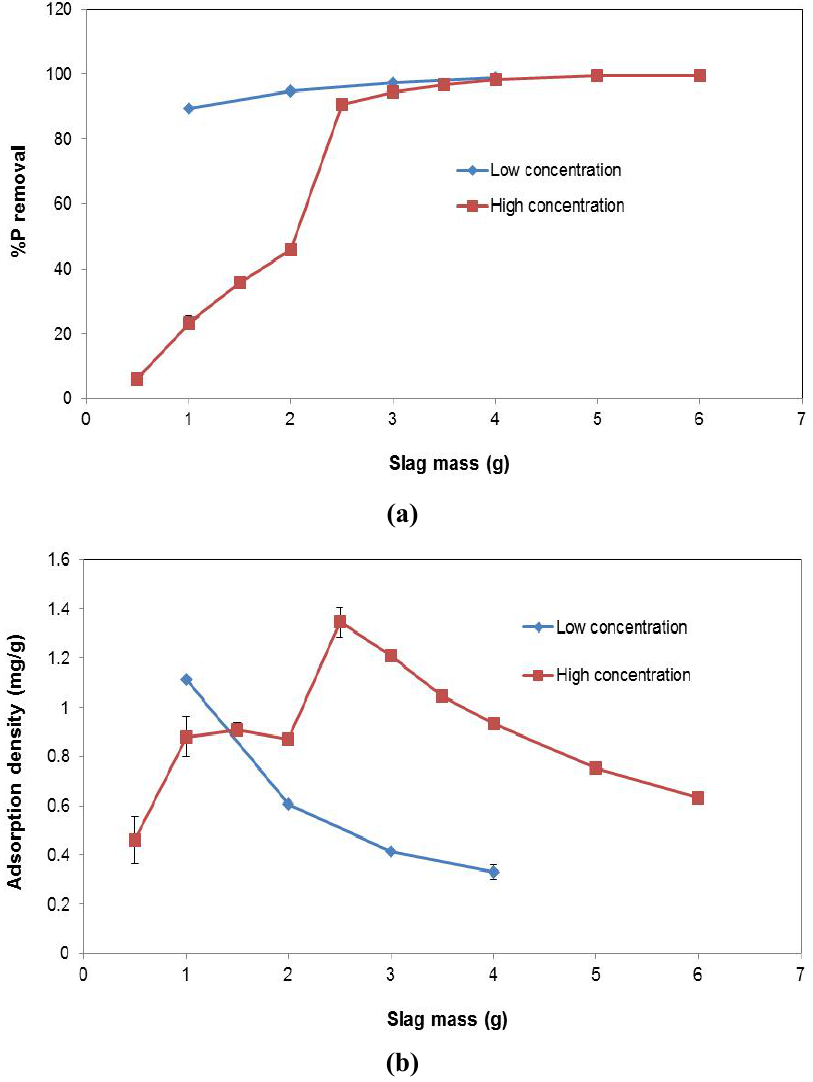
Figure 6. Effect of varying slag mass across different P concentrations on ( a ) P conversion (%); ( b ) Adsorption density (mg P/g).